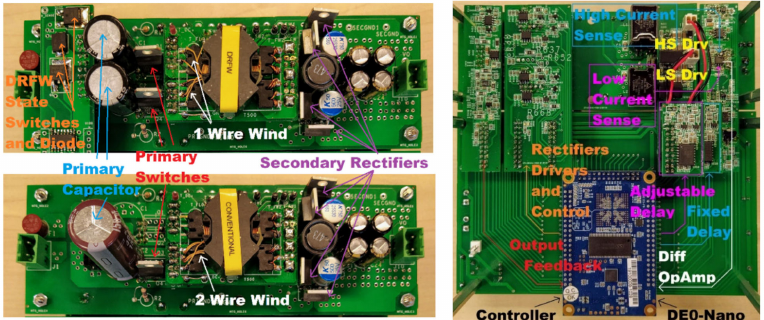
Figure 8. Power board of DVFW ( top left ), conventional forward ( bottom left ) and the current sharing control ( right ).